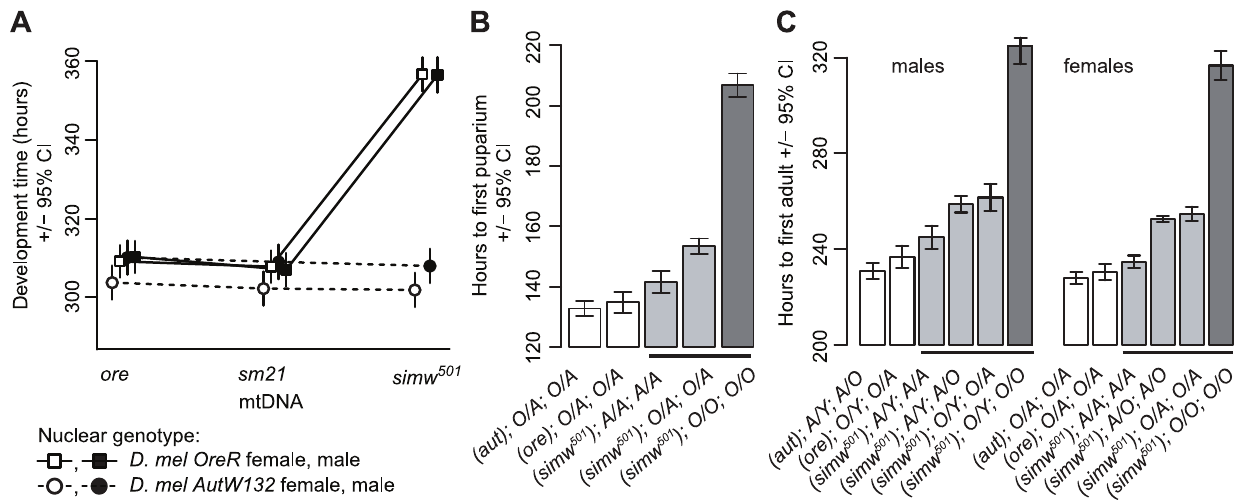
Figure 1. Effects of a mitochondrial–nuclear interaction on development. (A) Mitochondrial-nuclear interactions between the D. simulans simw 501 mtDNA and the D. melanogaster OreR nuclear genome significantly extend egg-to-adult development time in both sexes (mtDNA 6 nuclear interaction: P ANOVA # 0.0001, Table S1). The D. simulans sm21 mtDNA is closely related to simw 501 , but has no effect on development time relative to the D. melanogaster ore mtDNA. (B and C) Both larval development and metamorphosis are delayed in (simw 501 );OreR . Crosses between mitochondrial-nuclear genotypes indicated that the OreR nuclear effect on development is similar in males and females, autosomal and largely recessive ( h =0.18, 0.19 and 0.23, for pupation time, and male and female eclosion times, respectively, where h =0 is complete dominance of AutW132 and h =0.5 is additivity). Listed below the graphs are the ( mtDNA ); sex chromosome ; autosome genotypes ( O = OreR , A = AutW132 ). O/A and A/O heterozygotes indicate the offspring of reciprocal crosses and differ in the parent-of-origin of the autosomes ( maternal / paternal ). The difference in time from egg to pupation between ( simw 501 ); AutW132 and ( simw 501 ); OreR is approximately 65 hours. The difference in time from egg to adult emergence between ( simw 501 ); AutW132 and ( simw 501 ); OreR is 80 and 82 hours in males and females, respectively. The 65 hour delay in larval development and the additional 15–17 hour delay during metamorphosis between ( simw 501 ); AutW132 and ( simw 501 ); OreR are both statistically significant ( P t-test , 0.001).